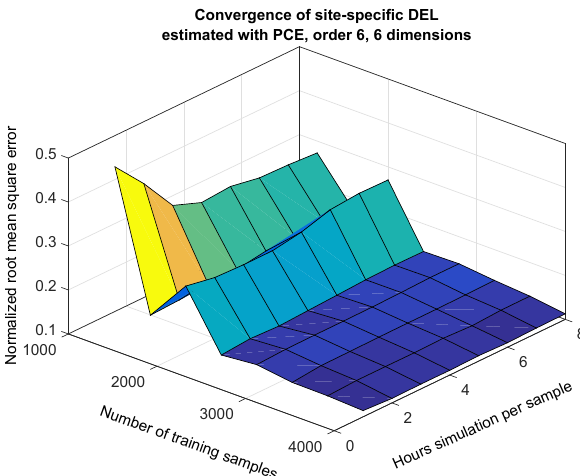
Figure 5. Convergence of an importance sampling (IS) calculation of the blade root moment from the high-fidelity database towards site-specific lifetime fatigue loads for reference site 0 (Table